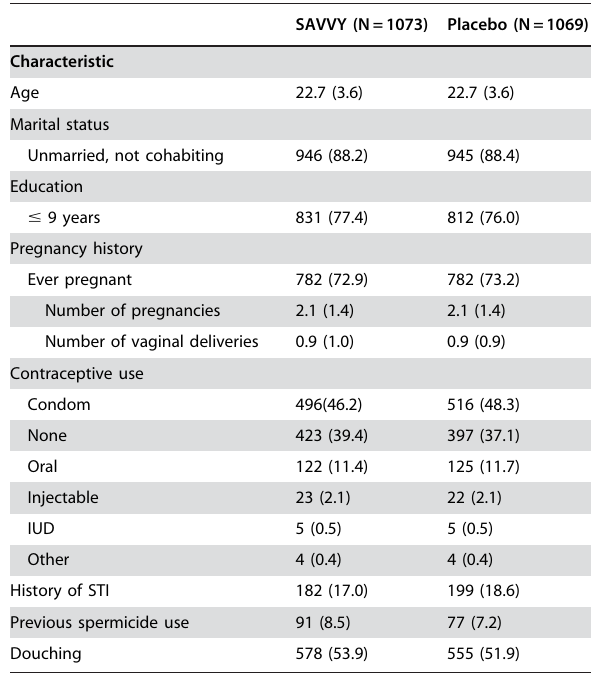
Table 1. Baseline Characteristics (ITT Population) .. ... .... ... ... .... ... ... .... ... ... .... ... ... .... ... ... .... ... ... .... .